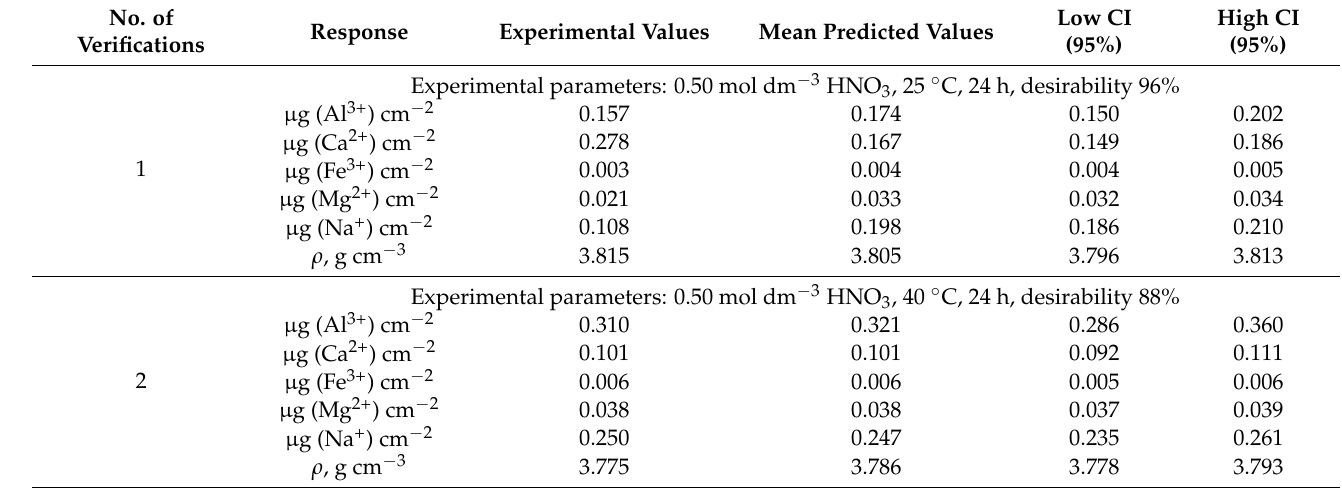
Table 10. Verification of experimental and calculated values of eluted ion amounts and alumina ceramic density at assessed optimal corrosion